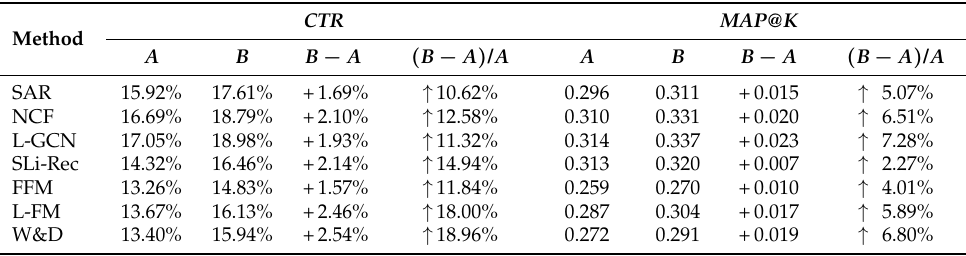
Table 5. The results of A/B experiments for narrational information in the Yahoo dataset ( A : w/o synopsis; B :